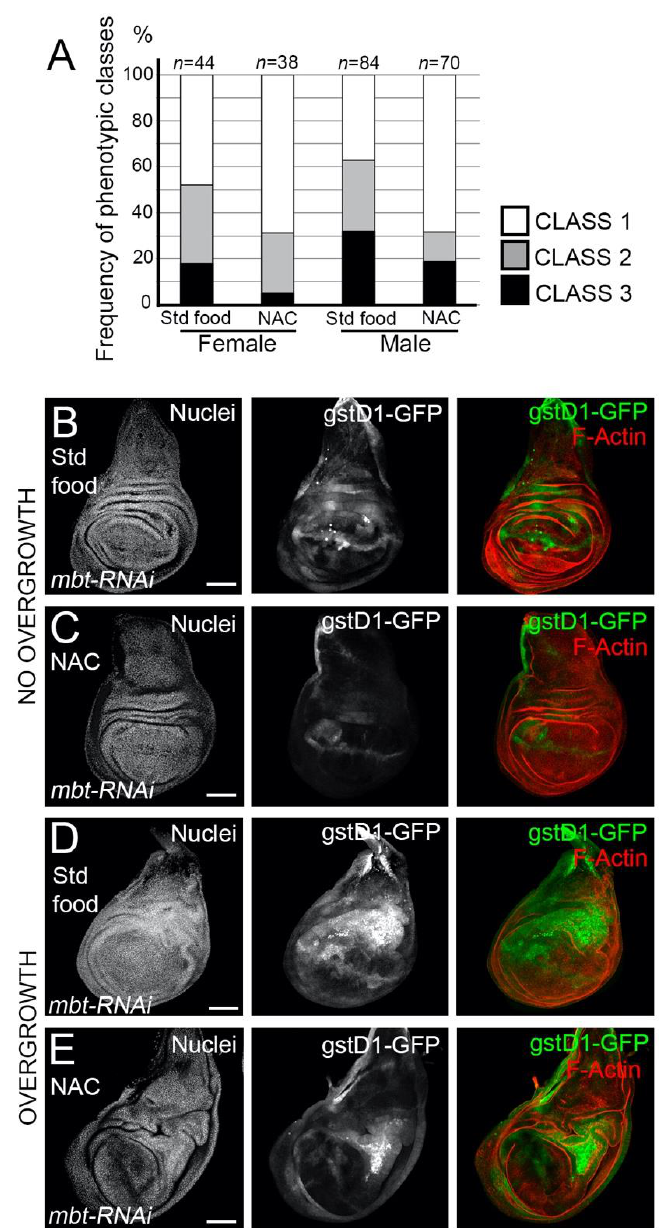
Figure 5. Effects of the ROS scavenger NAC on the mbt-RNAi phenotype. ( A ) Incidence of discs with overgrowth in mbt-RNAi fed with standard food or with food supplemented with NAC in females and males. ( B , C ) mbt-RNAi wing discs with no folding or overgrowths, but weak gstD1-GFP activation grown in standard food ( B ) and grown in food supplemented with NAC ( C ). ( D , E ) mbt-RNAi wing discs with severe folding and overgrowths with strong gstD1-GFP expression grown in standard food ( D ) and grown in food supplemented with NAC € . Discs were stained with TO-PRO3 (Nuclei; gray) and Phalloidin (F-actin; red). Scale bars: 50 µm. In this work, we have re-evaluated the potential of l(3)mbt mutants to generate over- growth in wing imaginal discs as firstly observed by Gateff and colleagues [12]. We also have shown that l(3)mbt mutant wing discs have an altered expression profile, which in- cluded a set of MBTS genes. Among the dysregulated genes in mbt mutant discs, we